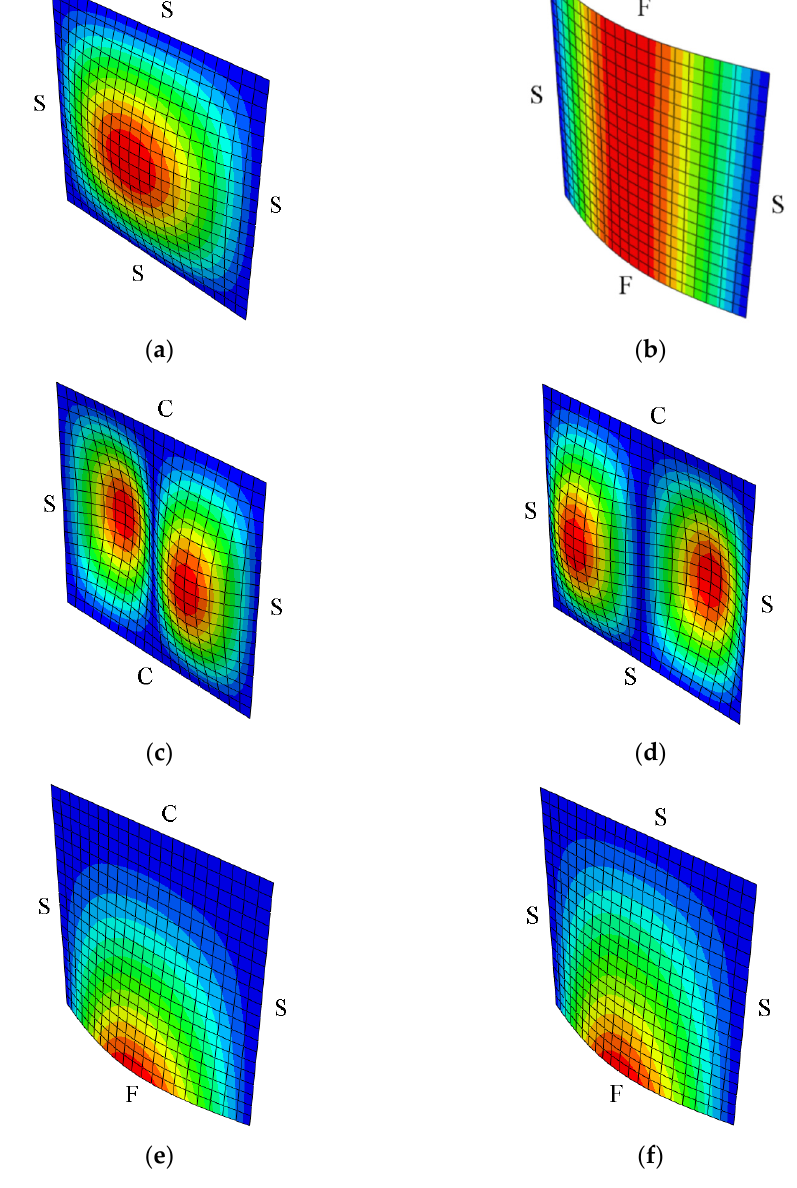
Figure 3. Fundamental buckling mode of cross ‐ ply 10 ‐ layer [0°/90°] 5 square composite plates with a variety of boundary conditions. The boundary conditions of each plate are as follows: ( a ) SSSS, ( b ) SSFF, ( c ) SSCC, ( d ) SSSC, ( e ) SSFC, ( f ) SSFS, and the corresponding values of 𝑁(cid:3365) : ( a ) 25.8350, ( b ) 11.9720, ( c ) 34.0600, ( d ) 32.1795, ( e ) 14.1590, ( f )